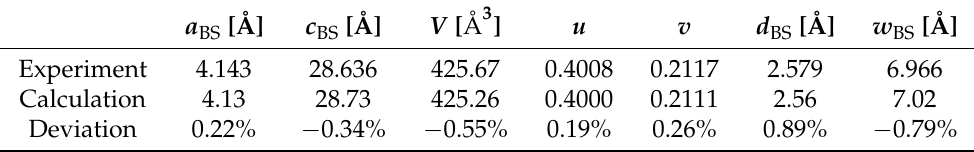
Table 1. Cell parameters for bulk Bi 2 Se 3 : the lateral lattice constant a BS of the hexagonal cell, the cell height c BS , the cell volume V , the Wyckoff position parameters of the trigonal cell u and v , the inter-layer distance d BS , and the layer thickness w BS . The experimental reference is taken from [26]. The calculations include spin-orbit coupling and van der Waals interactions (DFT-D2) during relaxation. The deviation of the calculations from the experiment is given as percentage.